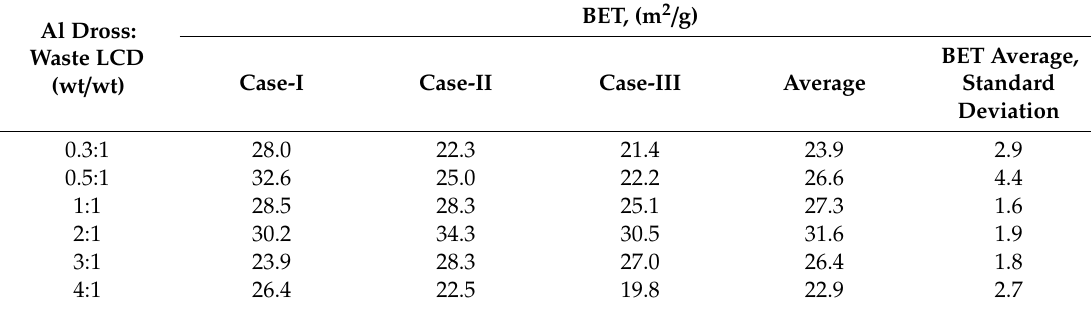
Table 2. Brunauer–Emmett–Teller (BET) analysis for zeolite synthesized using various conditions.